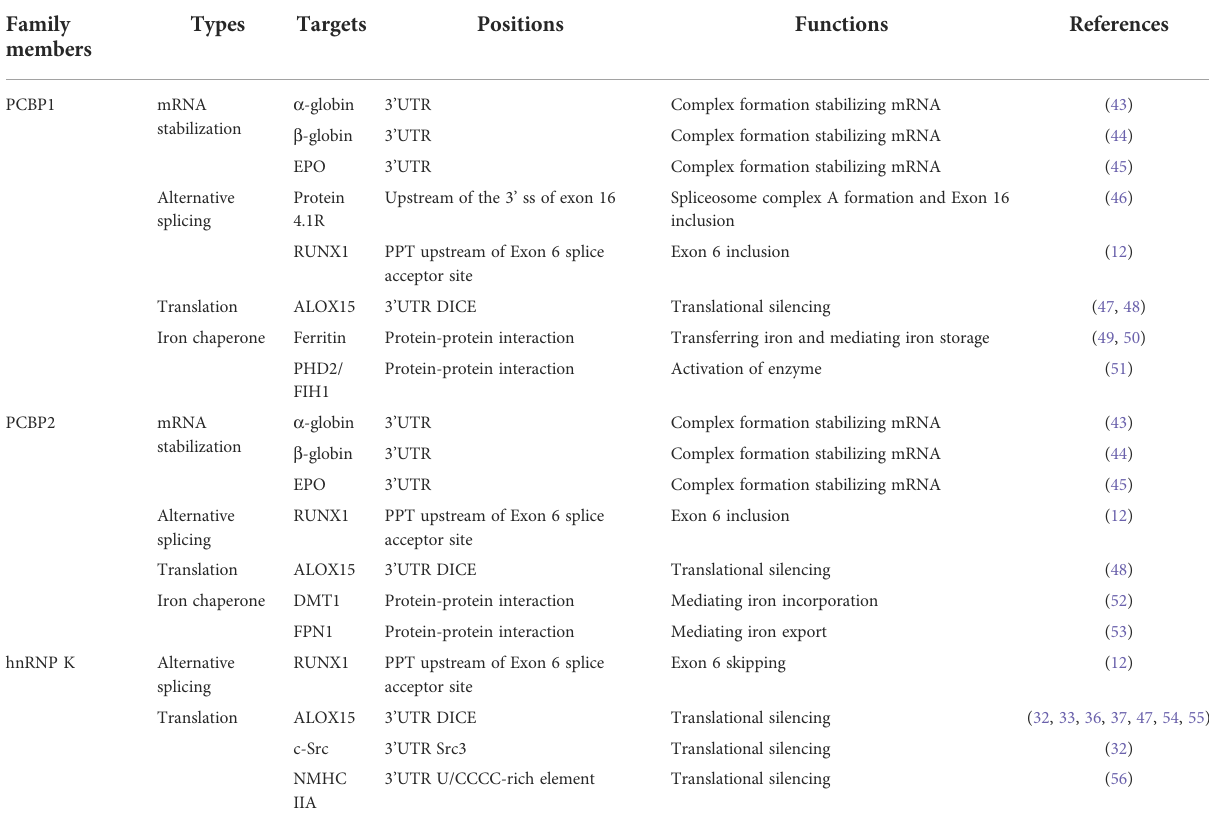
TABLE 1 The roles and underlying mechanisms of hnRNP K, PCBP1, and PCBP2 in erythroid differentiation and function. Family